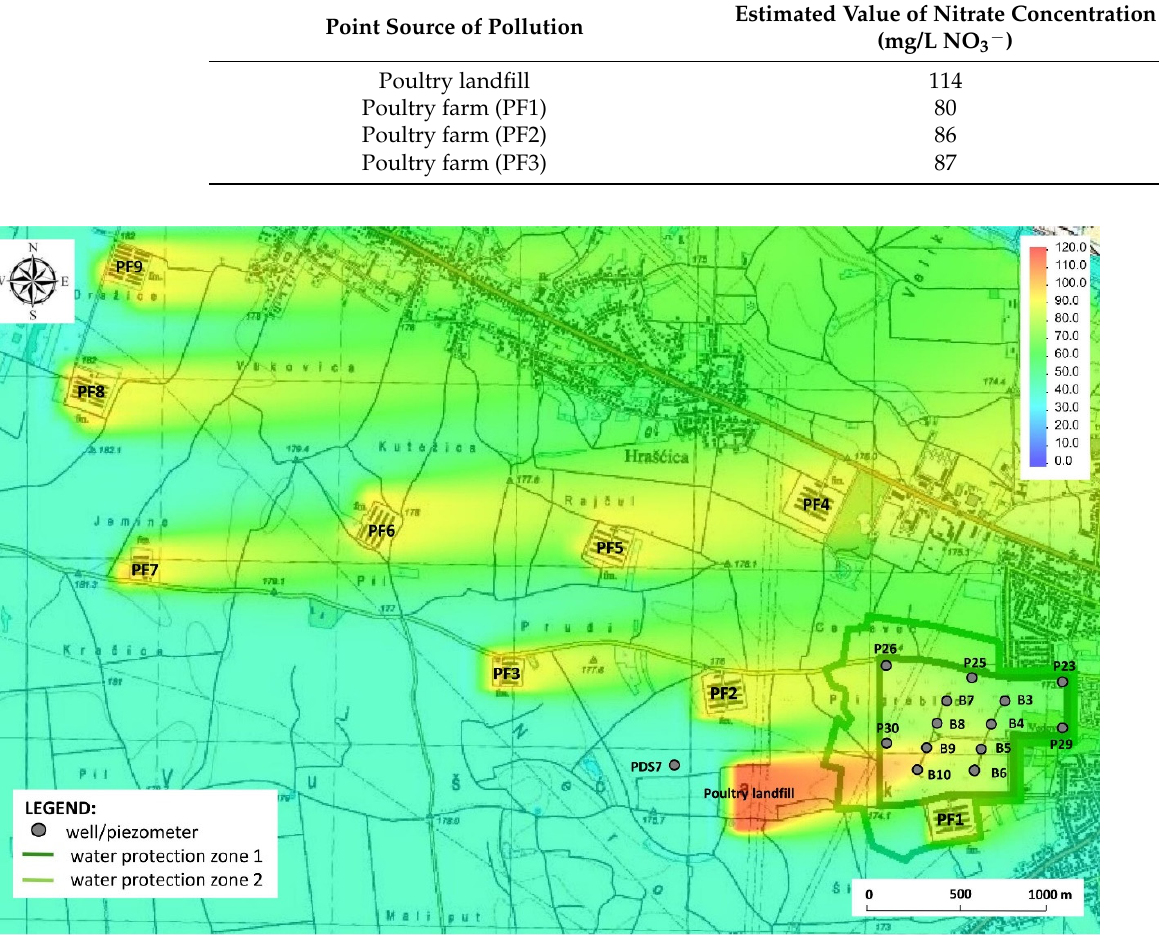
Figure 8. Nitrate pollution propagation by impulse initial conditions—100 days.